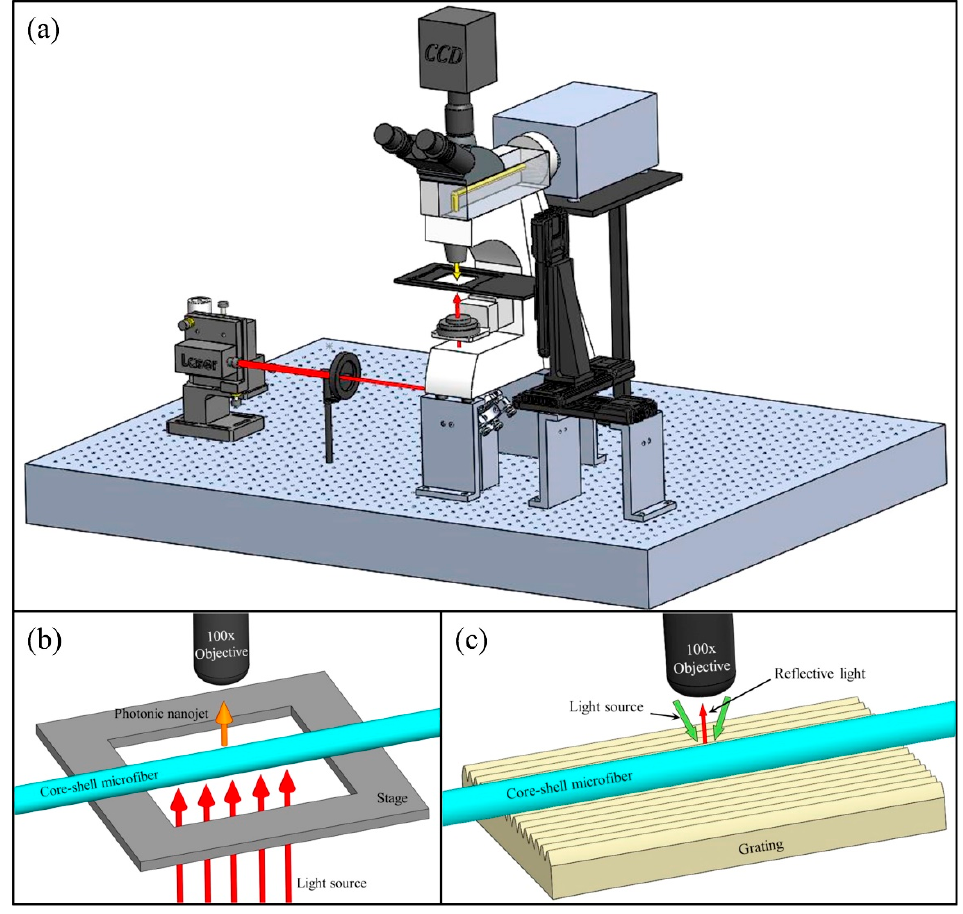
Figure 17. ( a ) Schematic diagram showing SRM microscopy performed. ( b ) Core-shell microfiber shown in the setup whereby the core shell consists of metallic films deposited by GLAD ( c ) Core shell microfiber placed on the top of the specimen. Reproduced with permission from